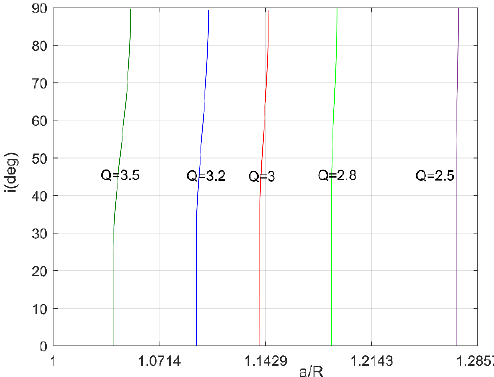
Figure 9. Inclinations of sun-synchronous repeating ground track orbits as a function of the semi- major axis, for different values of the repetition parameter Q .